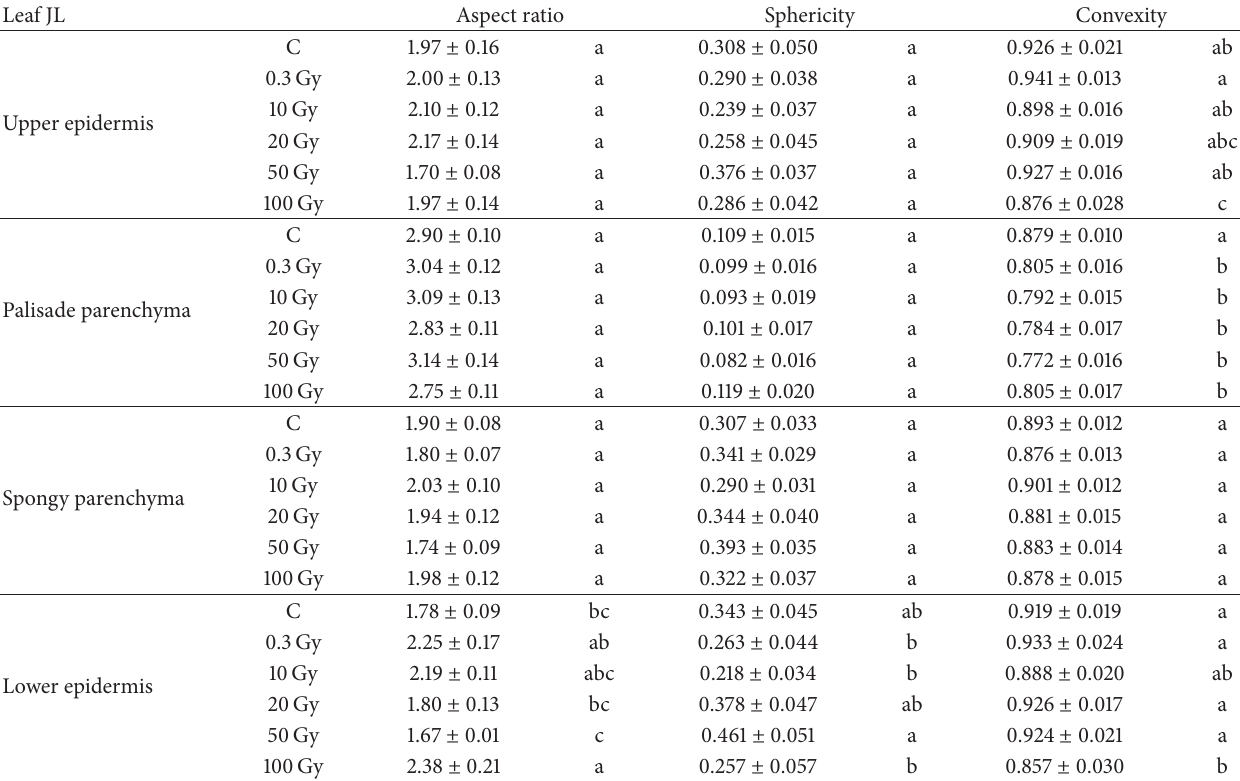
Table 1: Cell shape in different tissues of juvenile leaves of S. lycopersicum L. “Microtom”. Mean values ± standard errors are shown ( 𝑛 = 75 ). Different letters correspond to significantly different values according to multiple comparison tests ( 𝑃 < 0.05